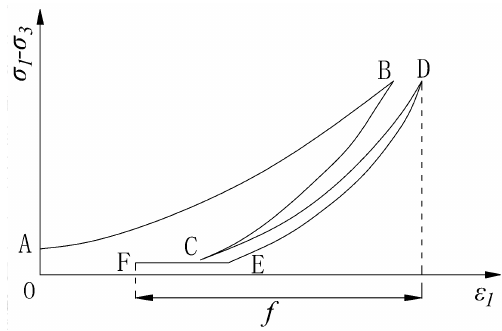
Figure 11. Schematic diagram showing the deviatoric stress-axial strain curves of different